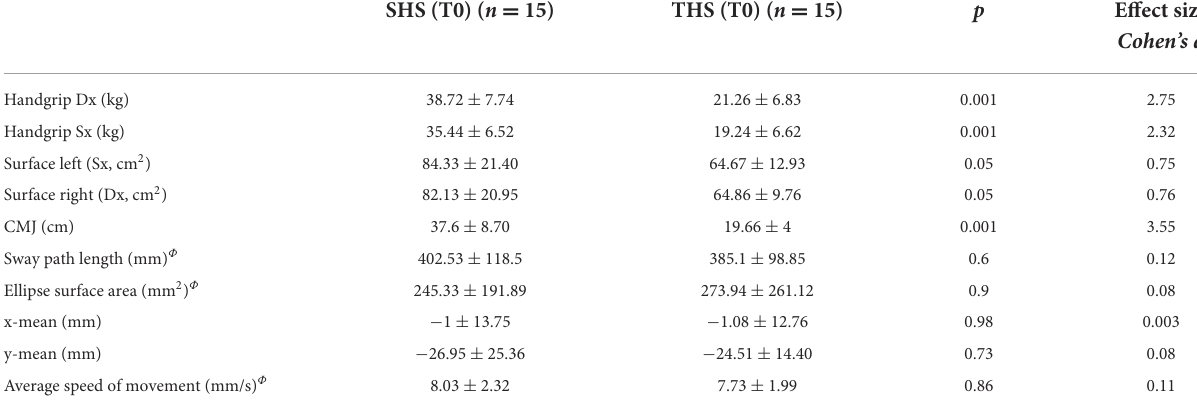
TABLE 2 Unpaired t-test analysis between SHS (T0) vs. THS (T0).